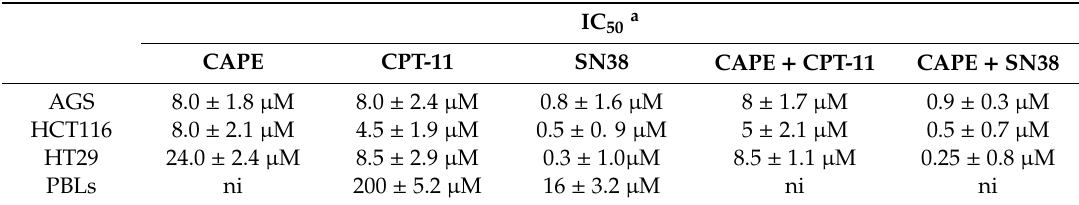
Table 1. Results of analysis of human cancer cell lines and peripheral blood lymphocytes viability after 72 h exposure to CPT-11, SN38 and CAPE at different concentrations compared to untreated control cells.